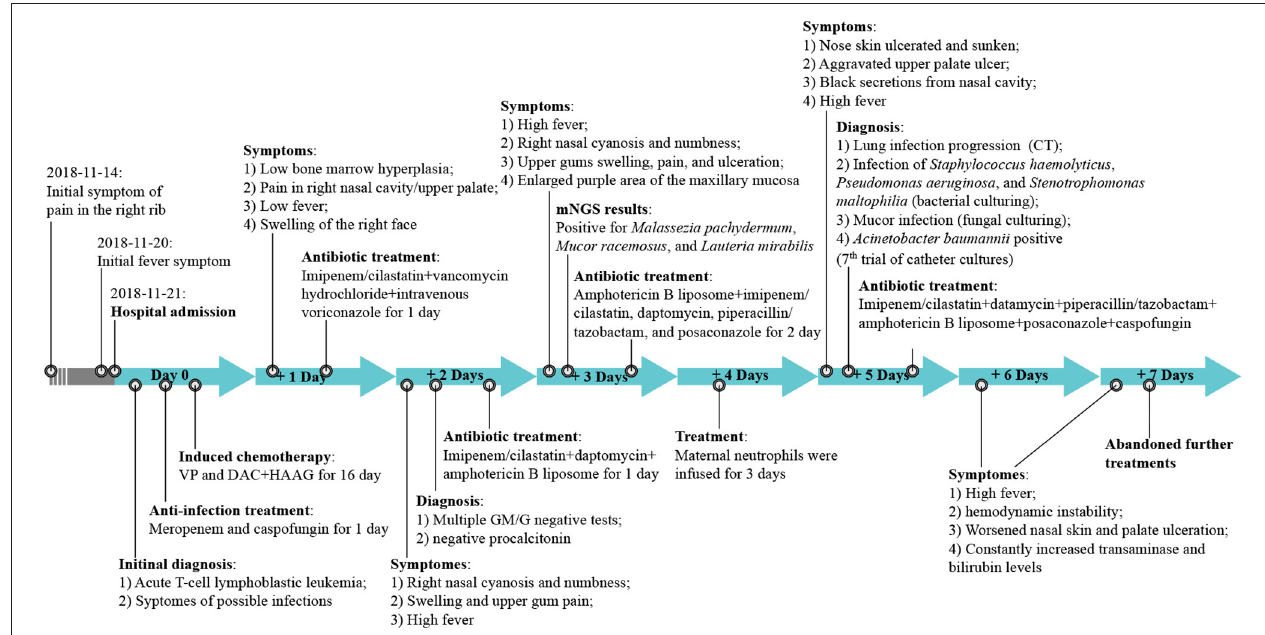
FIGURE 1 | The treatment timeline. VP, Vincristine + Prednisone; DAC, decitabine; HAAG, homoharringtonine (H), cytarabine (A), aclarubicin (A), granulocyte colony stimulating factor (G-CSF); CT, computed tomography; GM/M, β -D-Glucan (G); Galactomannan (GM) tests; mNGS, metagenomic next-generation